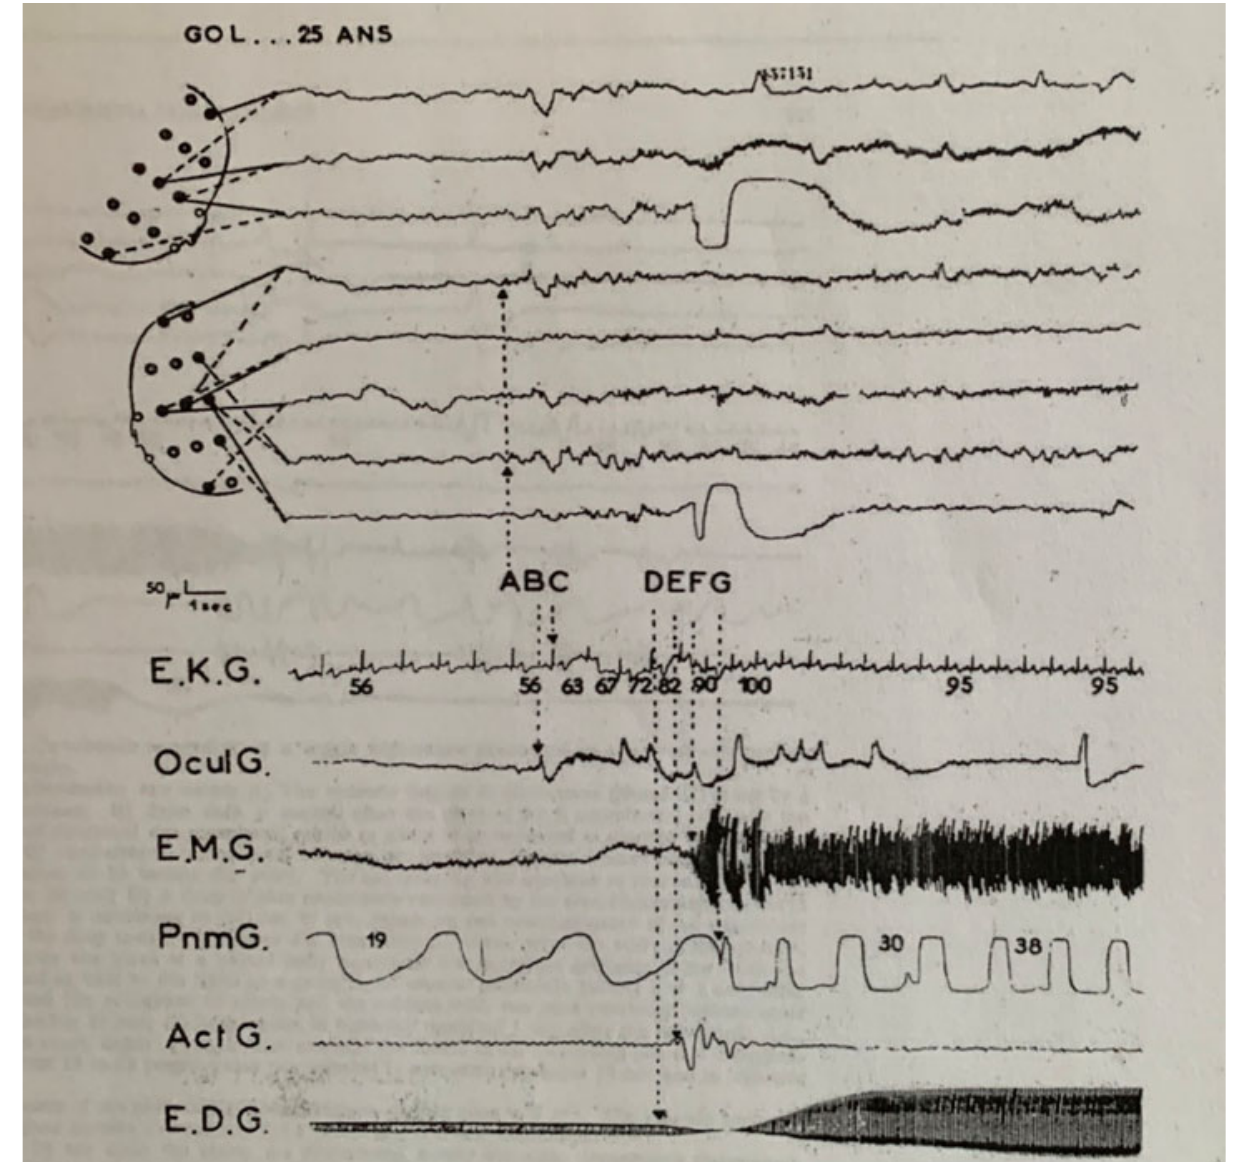
Figure 9. The onset of a sleep terror. It begins in slow ‐ wave sleep and exhibits features of a very intense abrupt awakening. In rapid succession one documents (A) a brief increase in EEG slow waves; (B) an eye movement; (C) the onset of tachycardia; (D) the onset of a rapid decrease in skin resistance due to sweating; (E) movement on the actogram; (F) the beginning of tachypnea which rapidly doubles; (G) a notch on the respiratory channel due to the sudden increase in muscle tone. The recording continues in Figure 10. (Adapted from Gastaut, H. and Broughton, R.: A clinical and polygraphic study of episodic phenomena during sleep. Academic Address, in: Wortis, J. (Ed.), Re ‐ cent Advances in Biological Psychiatry, New York, Plenum Press, 1965, pp. 197–221).